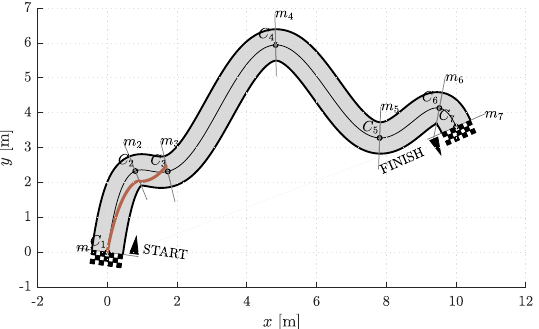
Figure 3. The racetrack model we used for the simulations. Shown are points C i on the centerline where the curvature is locally highest, and lines m i where P i